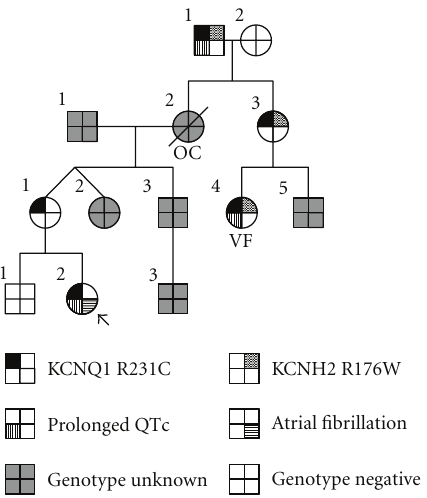
Figure 3: Family pedigree. Index patient (arrow). Ventricular fibrillation (VF). Obligate carrier